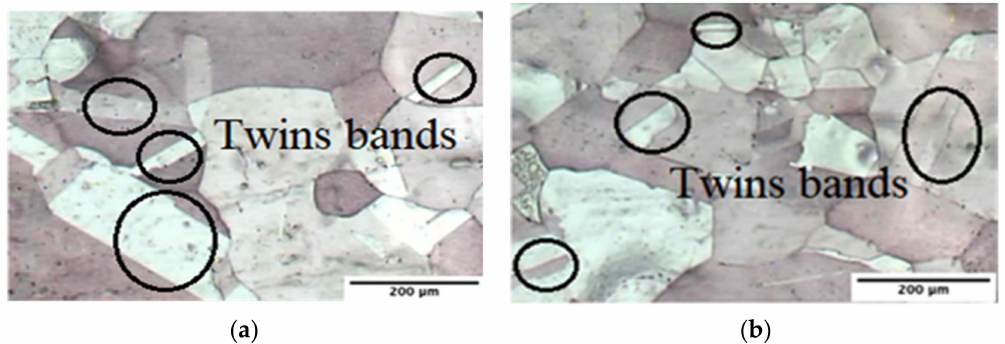
Figure 18. Optical microscope images of the Cu sheet samples produced by the modified-CSP techniques in ( a ) first pass and ( b ) tenth pass.